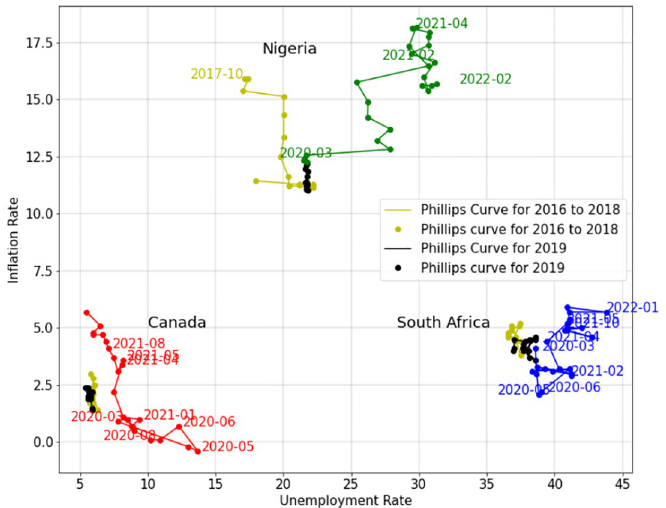
Fig 4. Phillips curve. Phillips curve of Canada, South Africa, and